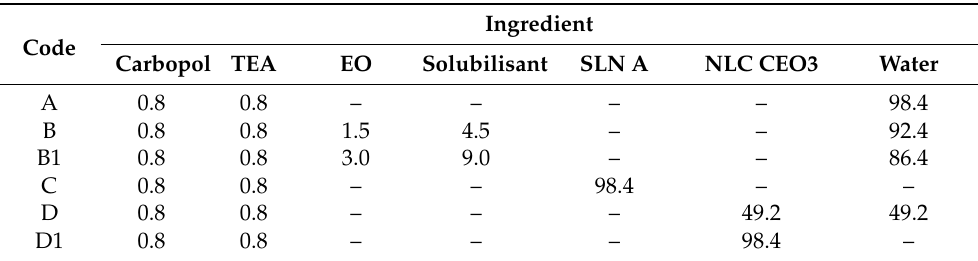
Table 2. Gel composition (% w / w ). Water contained 0.35% w / w imidazolidinyl urea and 0.05% w / w methylchloroisothiazolinone and methylisothiazolinone as preservatives. Ingredients include Carbopol, Triethanolamine (TEA), essentials oils, Solubilisant, solid lipid nanoparticles (SLNs) preparation A, lipid nanoparticles (NLCs) preparation CEO3 and